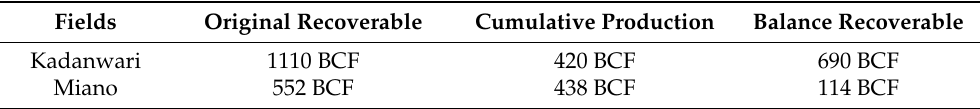
Table 6. The gas reserves of the Kadanwari and Miano fields as of 30 June 2011.